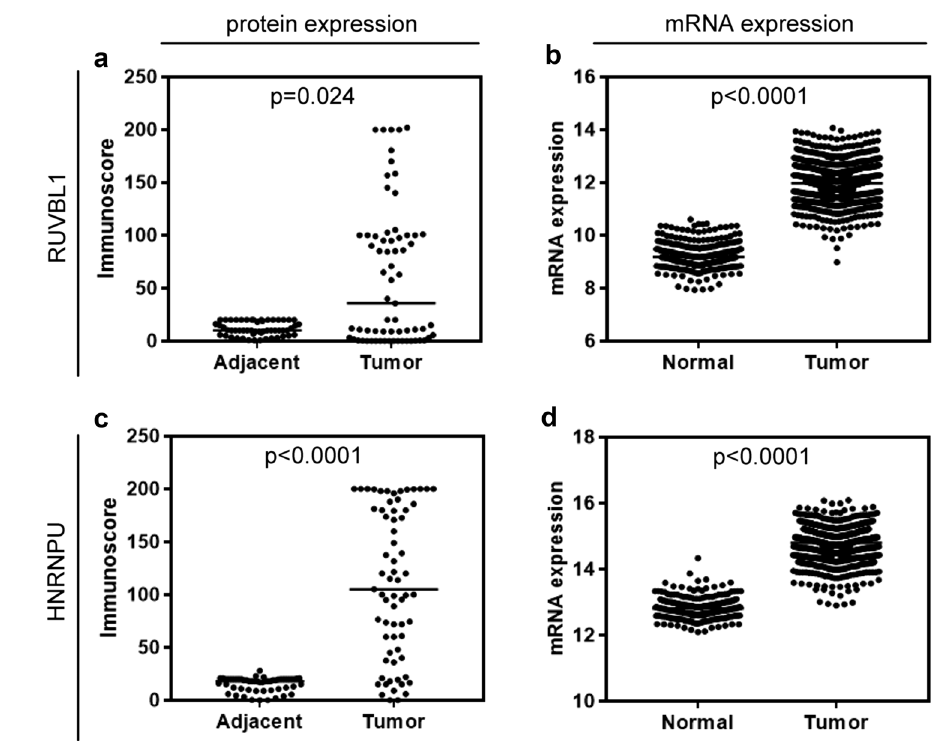
Fig. 2 Protein and mRNA expression of RUVBL1 and HNRNPU in tumor and adjacent tissues in NSCLC. a RUVBL1 protein expres- sion levels in NSCLC tumors compared to noncancerous adjacent tissues; b RUVBL1 mRNA expression levels in NSCLC tumors compared to normal tissues; c HNRNPU protein expression levels in NSCLC tumors compared to noncancerous adjacent tissues; d HNRNPU mRNA expression levels in NSCLC tumors compared to normal